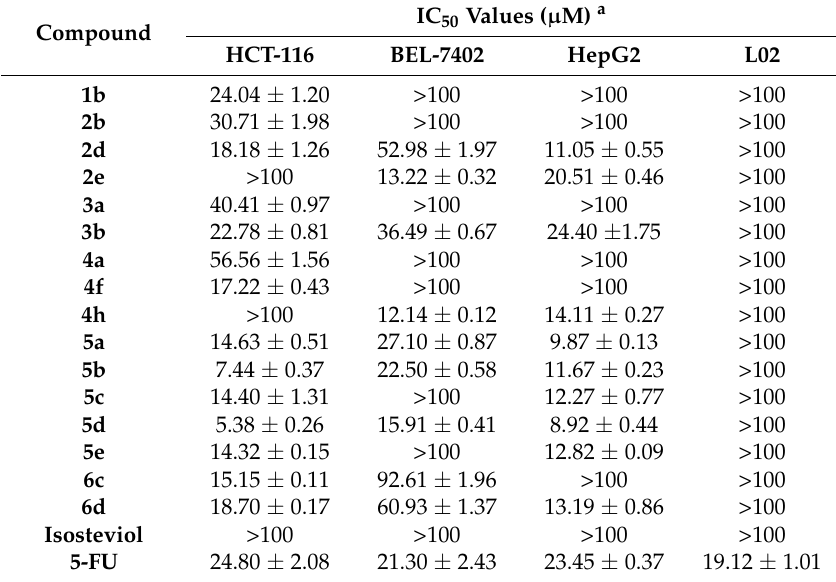
Table 2. IC 50 values ( µ M) of several active compounds.